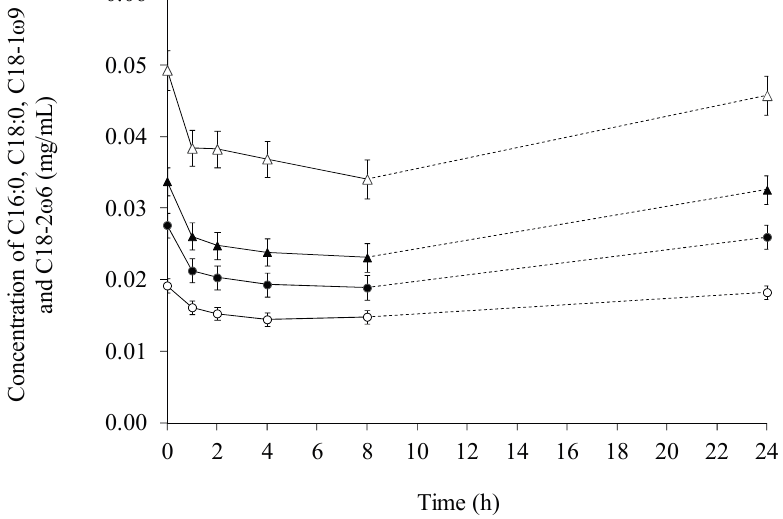
Figure 5. The concentration (mg/mL) of palmitic (16:0, ● ), stearic (18:0, ○ ), oleic (18:1 ω 9, ▲ ), and linoleic (18:2 ω 6, ∆ ) in serum across diets over time.